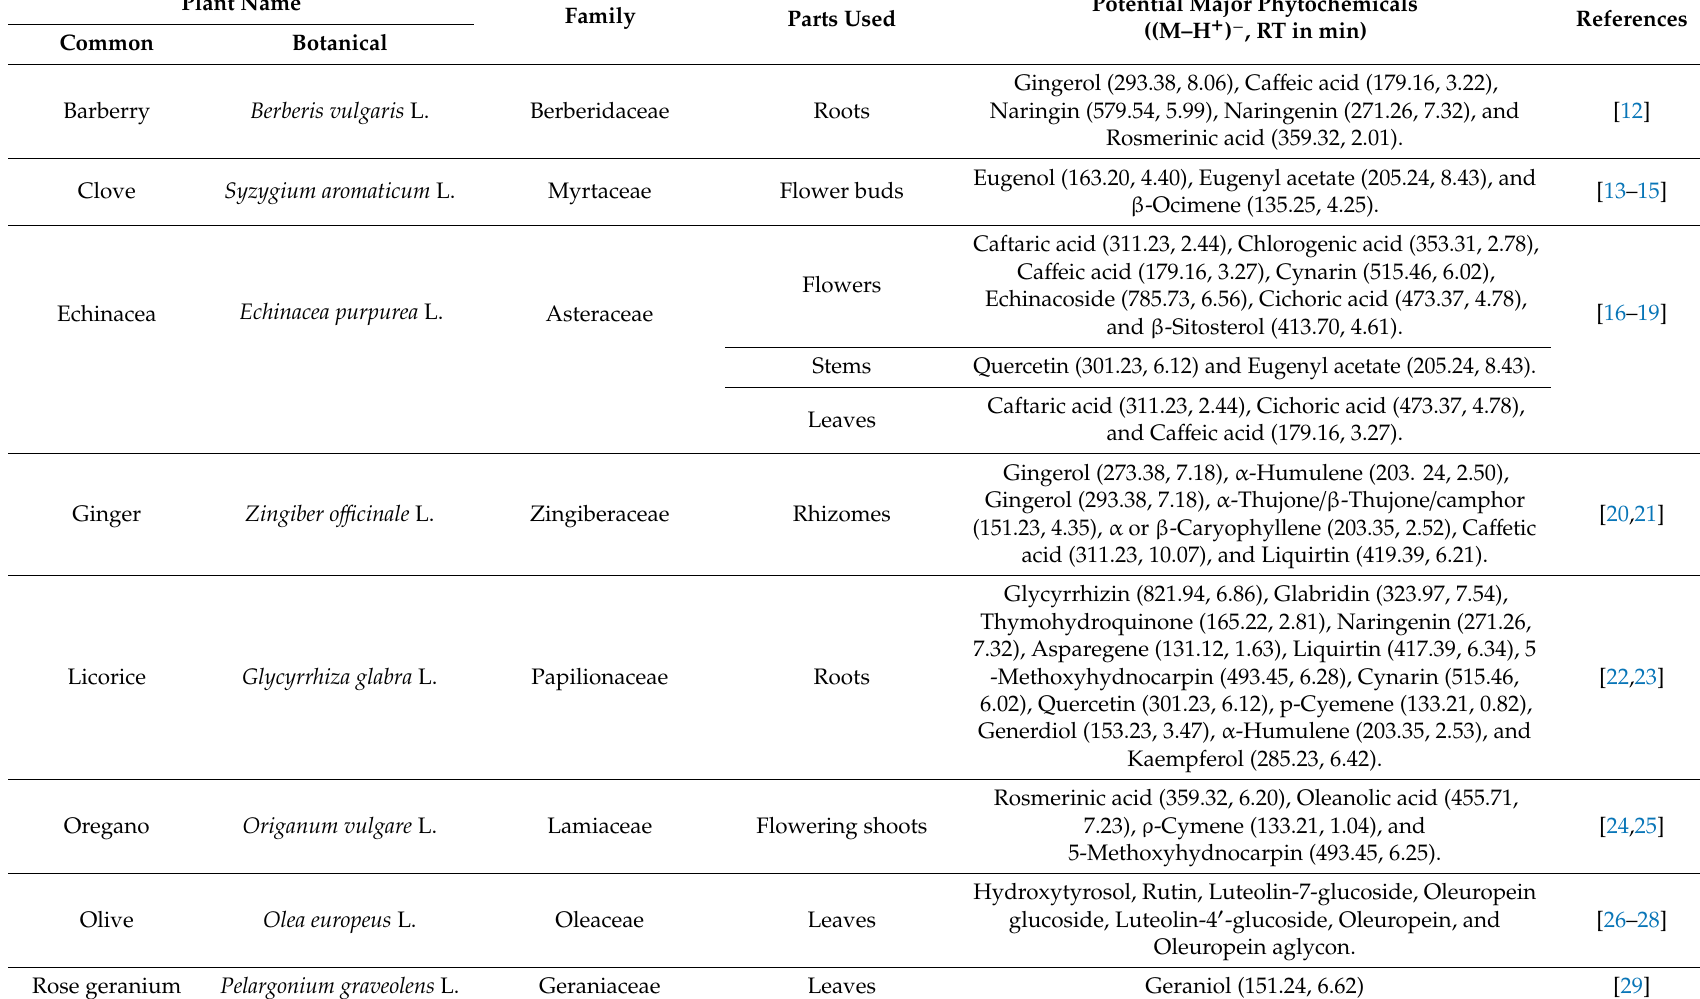
Table 1. Potential phytochemical profile of the selected herbal plant